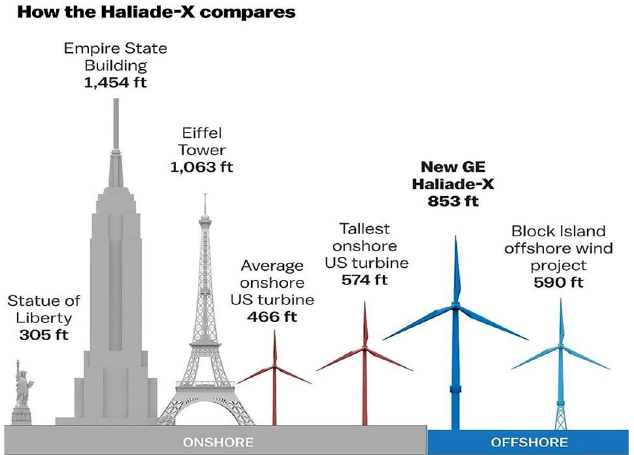
Fig. 21. Height comparison of